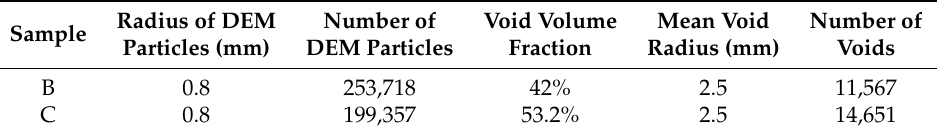
Table 5. DEM models for samples B and C: Number and size of DEM particles and representation of the air pores.